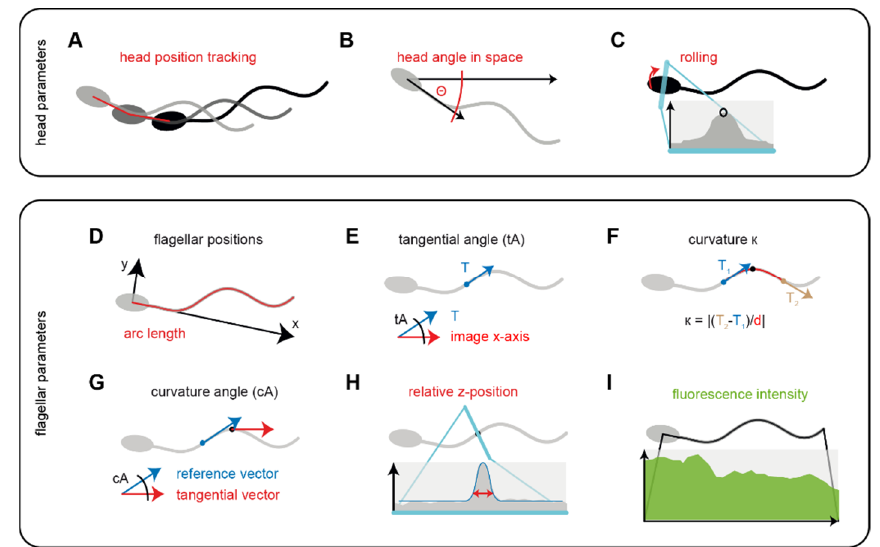
Figure 3. SpermQ output parameters. SpermQ output parameters characterize the orientation of the head in space ( A – C ) or each individual position on the flagellum ( D – I ). SpermQ outputs the head position in space over time ( A ) the angle Θ ( B ), which is the angle of the head midpiece axis to the x-axis. The maximum intensity (black circle) in a cross-sectioning line through the head center describes sperm rolling around its longitudinal axis ( C ). To determine the x- and y-positions of the flagellar points relative to the head, all flagellar points are translated into a coordinate system originating from the center of the head ( D ); the initial part (Table 1P) of the flagellum defines the x-vector of the coordinate system. Tangential angles are determined at each position as the angle between the tangential vector at the position and the x-axis of the image ( E ); the curvature ( F ) of a given point on the flagellum is determined as the geometric curvature and by using the tangential vectors (T 1 and T 2 ) at a defined distance d; d can be set by the user (see Table 1Q) and, here, was set to 10 µ m (taking the points 5 µ m up- and downstream into account for calculating the curvature). For arc lengths close to the head or the flagellar tip, a smaller distance is chosen. The curvature angle (cA) at a given point is calculated by the angle between the tangential vector at the given point and the tangential vector of the point at a defined distance (Table 1Q) before the given point ( G ); as a relative parameter for the flagellar z-position, SpermQ outputs the width of the Gaussian curve fitted to the intensity profile of the normal vectors at every point of the flagellum ( H ); furthermore, the maximum intensity of every flagellar point is measured to generate an intensity profile along the flagellum ( I ).